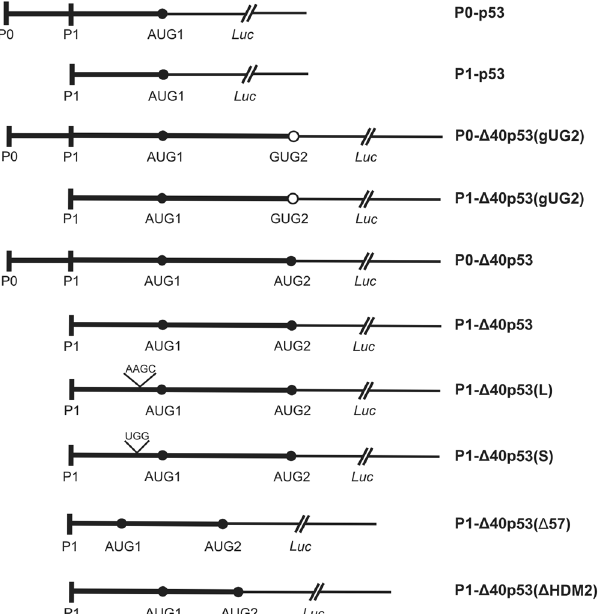
Figure 1. Schematic representation of the RNA constructs consisting of various 5 ′ -terminus of p53 mRNA and the Renilla luciferase coding region. P0 and P1 stand for transcription promoter regions while AUG1 and AUG2 indicate translation start codons. The codon AUG2 was mutated to GUG codon for valine in the P1- Δ 40p53(gUG2) and P0- Δ 40p53(gUG2) constructs. Nucleotide substitutions in the P1- Δ 40p53(L) and P0- Δ 40p53(S) constructs are marked on the scheme. In the P1- Δ 40p53( Δ 57) and P1- Δ 40p53( Δ HMD2) constructs two hairpin motifs were mutated (see Fig.